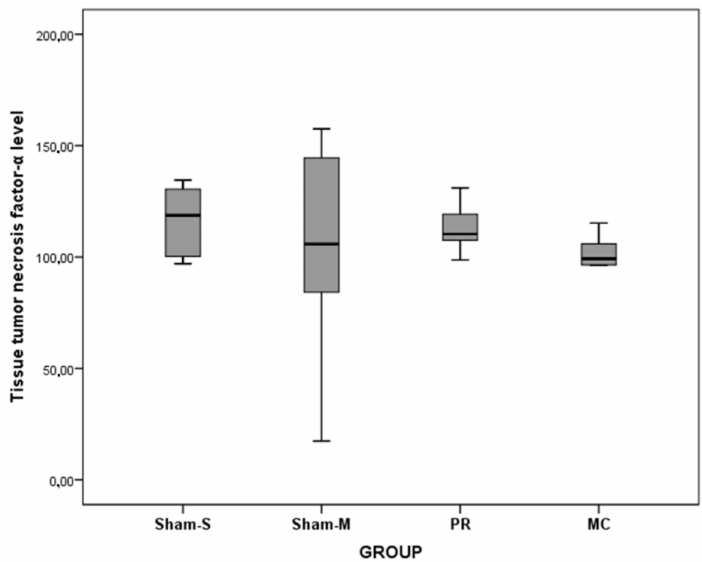
Figure 7. Tissue tumor necrosis factor- α level values of all